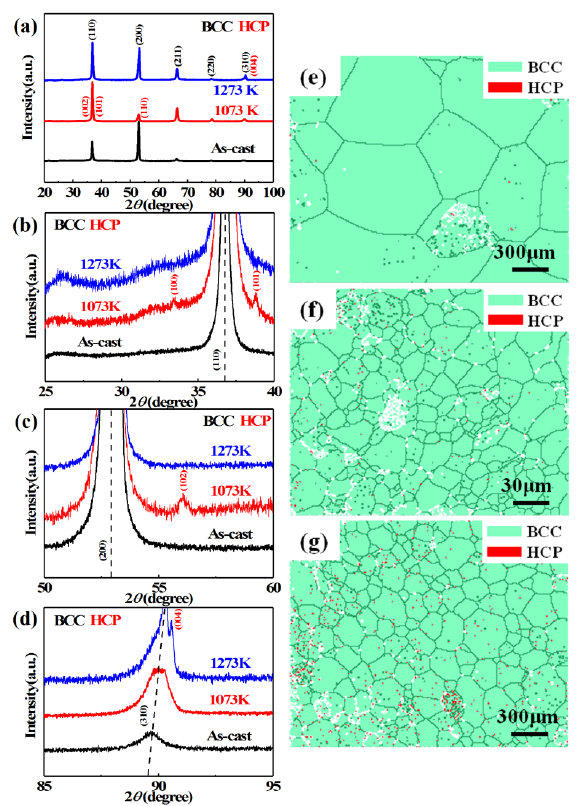
Figure 1. Phase structure of the Nb 25 Ti 25 Hf 25 Zr 25 refractory high entropy alloy (RHEA). ( a ) XRD patterns of the RHEAs in as-cast, cold rolled-and-annealed at 1073 K and 1273 K states; ( b – d ) Enlarged XRD patterns of the RHEAs at di ff erent states; ( e ) Electron back scattering-di ff raction (EBSD)image of the as-cast RHEA; ( f ) EBSD image of cold-rolled RHEA followed annealing at 1073 K; ( g ) EBSD image of cold-rolled RHEA followed annealing at 1273 K. The white area is the one without Kikuchi patterns during EBSD scanning which cannot be determined in EBSD-data analyzing software. The occurrence of such area is due to residual stress.